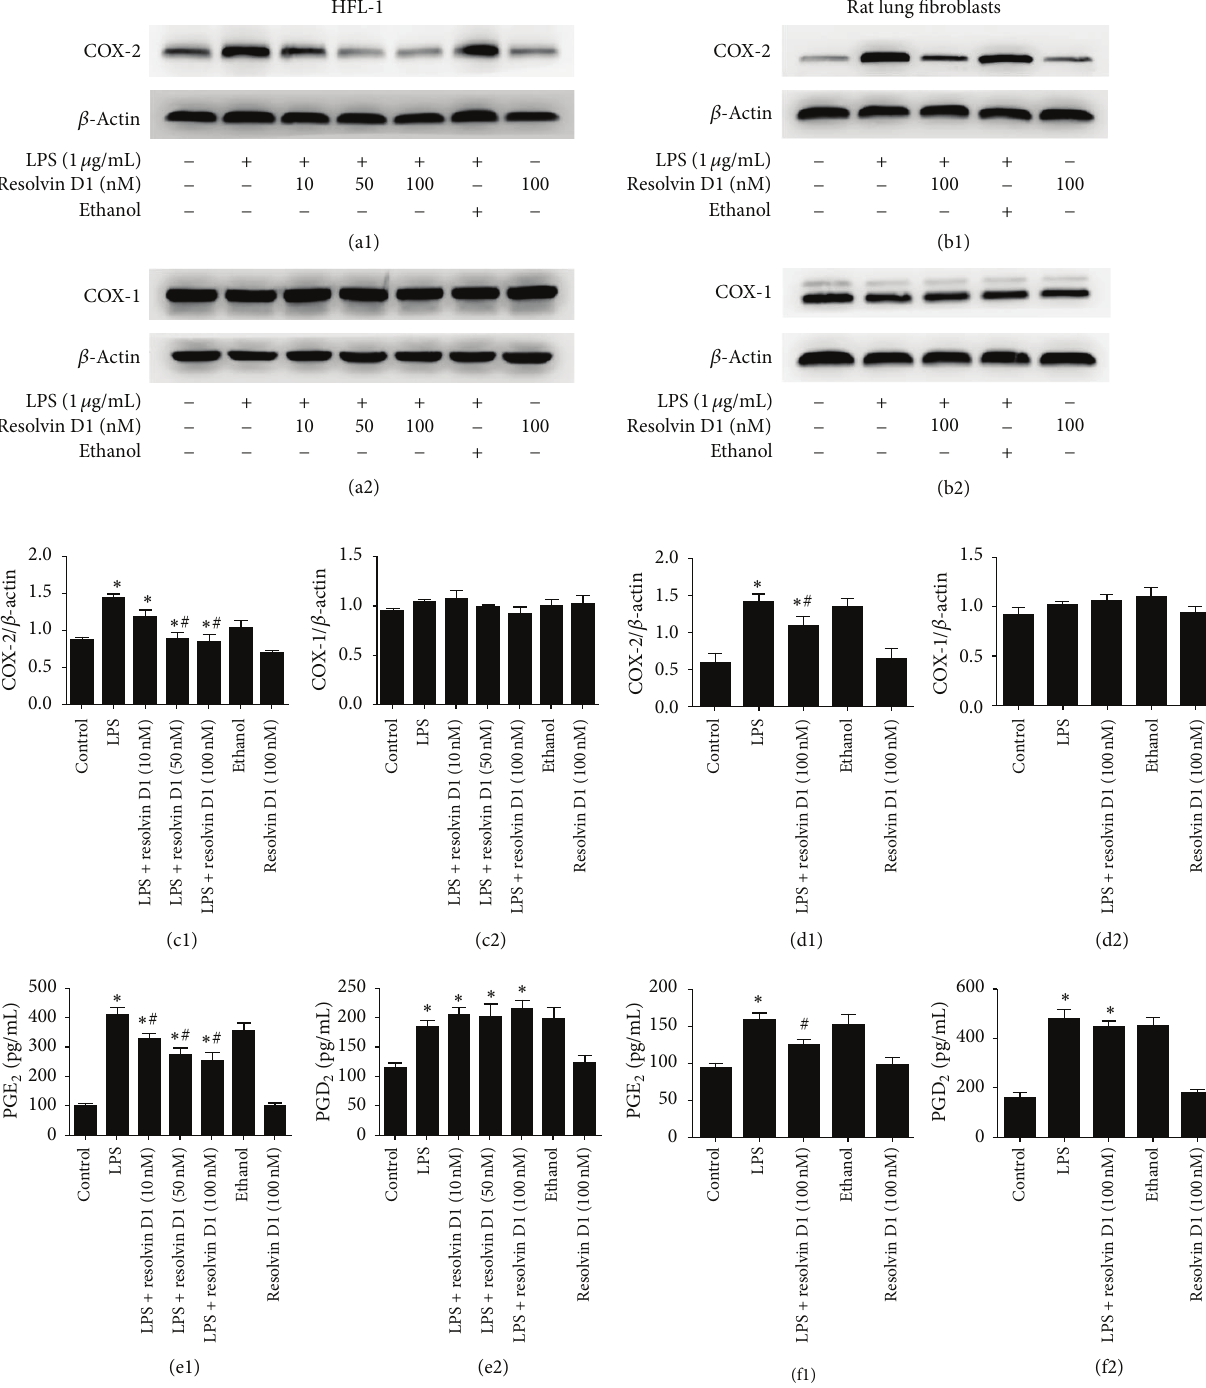
Figure 2: The effect of resolvin D1 on expression of COXs (COX-1 and COX-2) and PGE 2 and PGD 2 production at 6 hours in lung fibroblasts stimulated with LPS. ((a1), (a2), (c1), (c2)) HFL-1 cells were treated with resolvin D1 at 0, 10, 50, or 100nM in the presence of LPS (1 𝜇 g/mL) for 6 hours. COX-2 protein was detected by western blot ( ∗ 𝑃 < 0.05 versus control, # 𝑃 < 0.05 versus LPS, LPS + resolvin D1 (10nM) groups). No significant change in the protein expression of COX-1 was observed after treatment with LPS in HFL-1 cells. ((e1), (e2)) Supernatants from HFL-1 cells treated with resolvin D1 at 0, 10, 50, or 100nM in the presence of LPS (1 𝜇 g/mL) for 6 hours were collected and PGE 2 protein was measured by ELISA. Data are expressed as mean ± SE for each group (e1) ( ∗ 𝑃 < 0.05 versus control, # 𝑃 < 0.05 versus LPS group). PGD 2 protein was also measured by ELISA. Data are expressed as mean ± SE for each group (e2) ( ∗ 𝑃 < 0.05 versus control). ((b1), (b2), (d1), (d2), (f1), (f2)) We also dulicated our test in primary rat lung fibroblasts ((b1), (d1)) ( ∗ 𝑃 < 0.05 versus control, # 𝑃 < 0.05 versus LPS group). ((b2), (d2)) No significant change in the protein expression of COX-1 was observed after treatment with LPS in primary rat lung fibroblasts. ( ∗ 𝑃 < 0.05 versus control, # 𝑃 < 0.05 versus LPS group, (f1)). ( ∗ 𝑃 < 0.05 versus control, (f2)). All experiments were repeated in